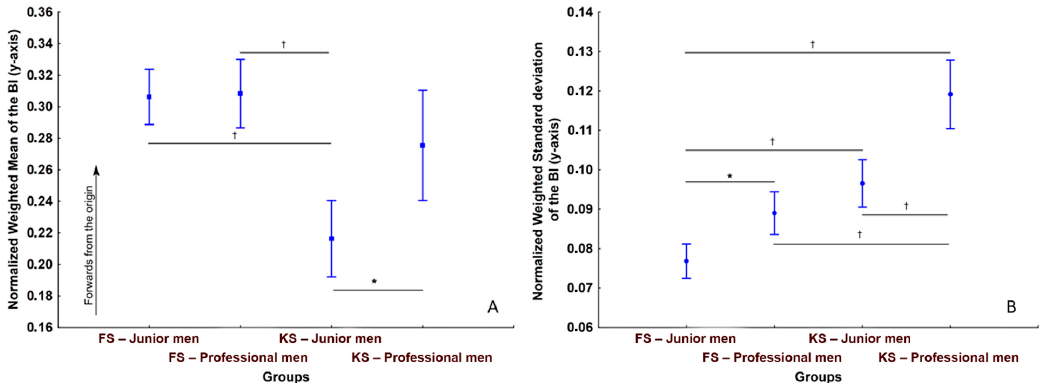
Figure 5. Differences in the ball impact location on the y -axis (professional and junior men). Note: FS—flat serve; KS—kick serve; * Significant differences between professional and junior men and the serve type, p < 0.05.; † Significant differences between professional and junior men and the serve type, p < 0.01 Vertical bars denote 95% CIs. Note: ( A ) normalized weighted mean of the ball impact, ( B ) normalized weighted standard deviation of the ball impact.